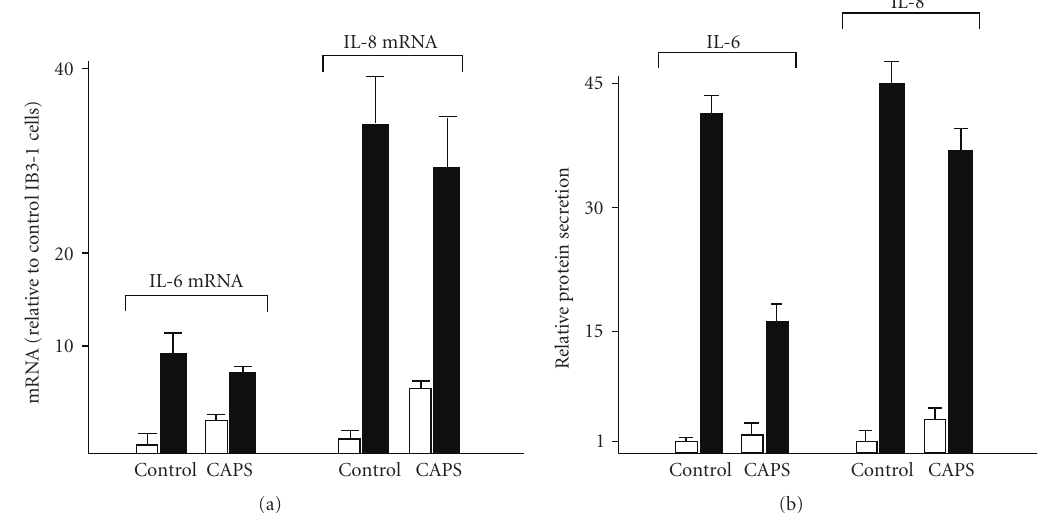
Figure 7: Analysis of the mRNA levels (a) and release (b) of interleukins 6 and 8 (IL-6, IL-8) by IB3-1 cells. Data are referred to control free cells growing as monolayer (control) and cells encapsulated in alginate microbeads (CAPS). Both free and encapsulated cells were cultured for 24 hours, in the absence (open bars) or in the presence of TNF- α (80ng/mL) (closed bars). Data represent the average ± SD ( N =